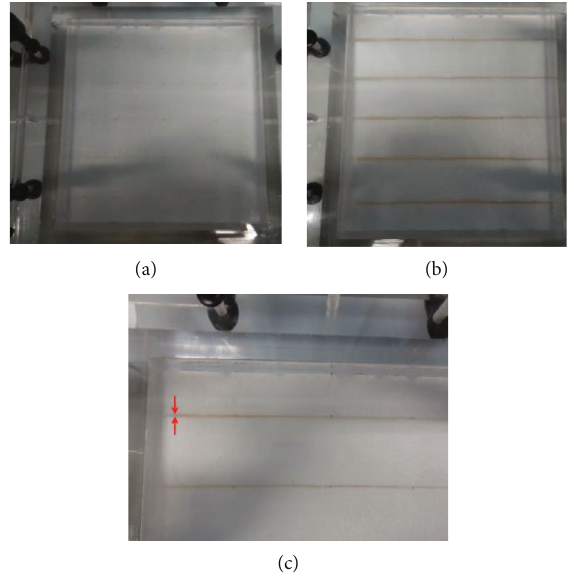
Figure 8: Average fracture aperture as a function of the pressure gradient.